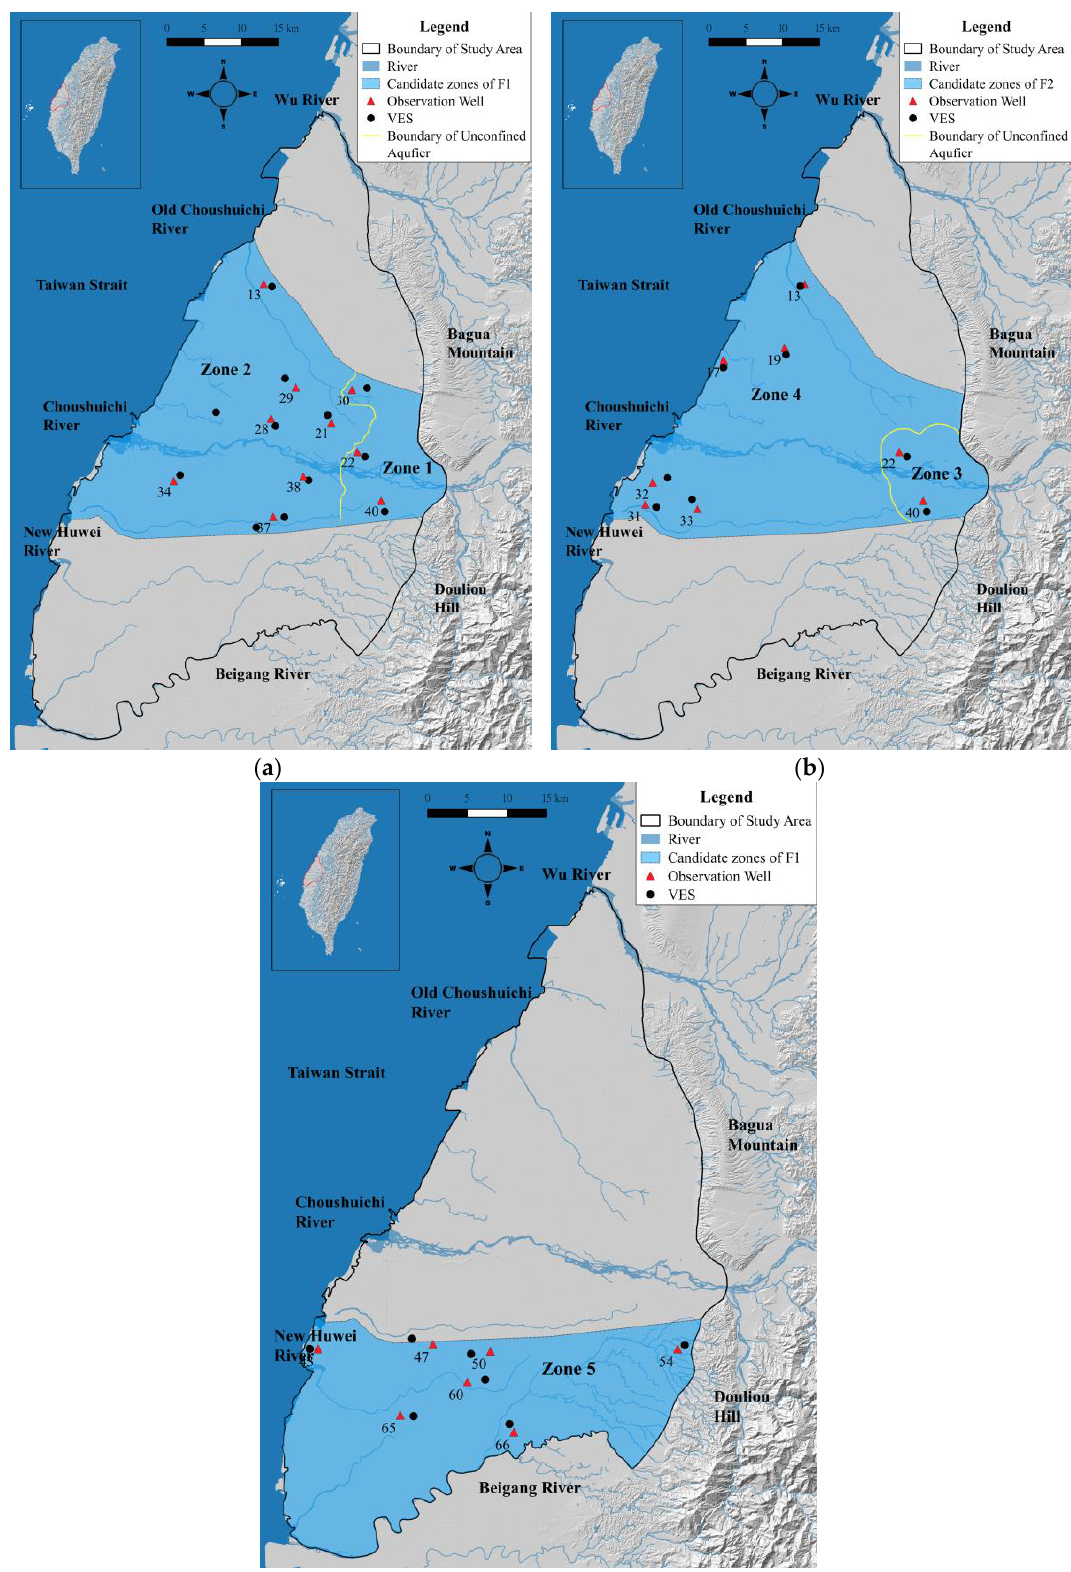
Figure 8 . Zonation results of the first and second aquifer. ( a ) Areas of zone 1 and zone 2; ( b ) areas zone 3 and zone 4; ( c ) area of zone 5.